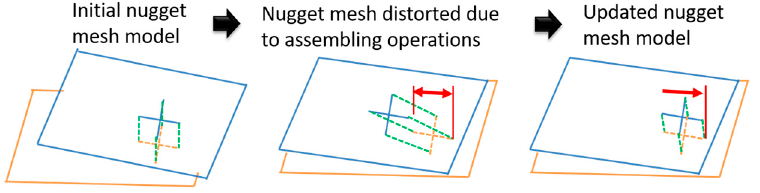
Figure 20. Nugget mesh model update for accurate prediction.